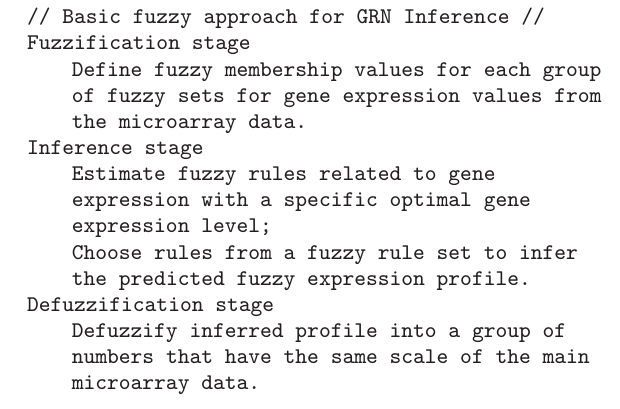
Algorithm 1: Fuzzy approach in GRN inference.